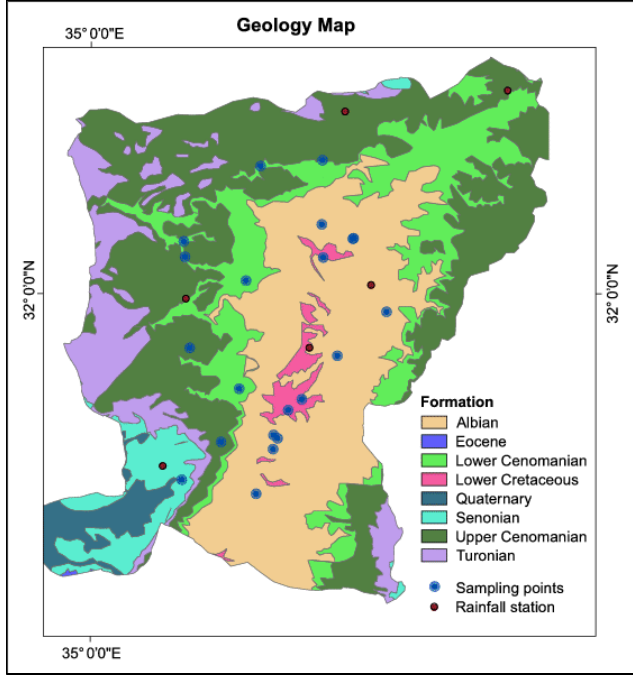
Figure 2. Geology map of the study area [12].